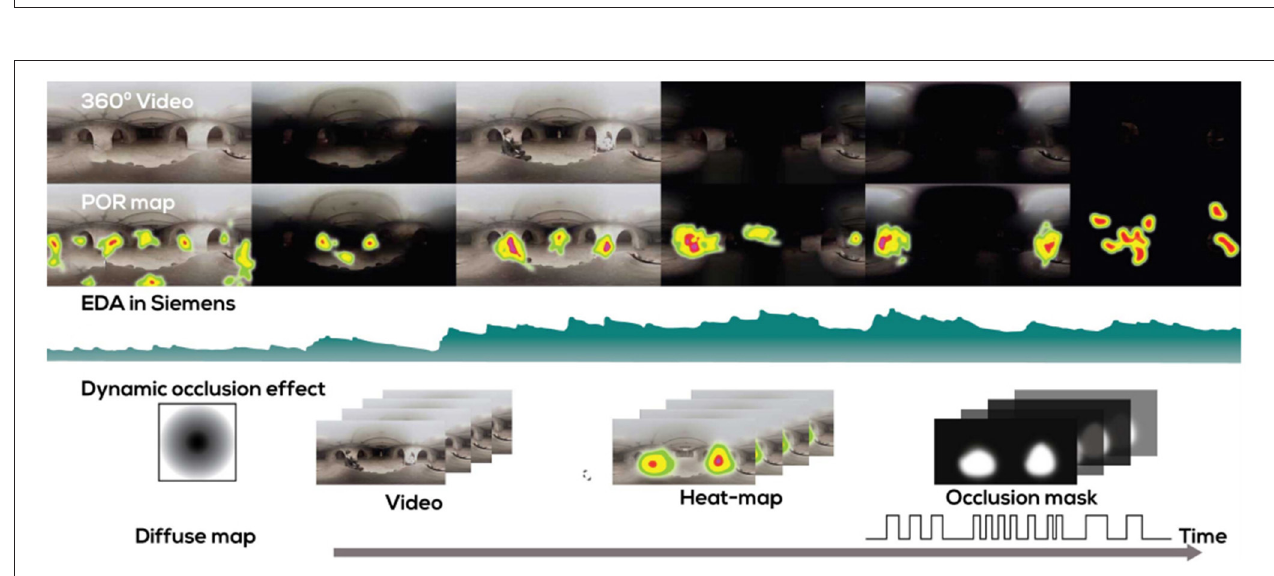
FIGURE 7 | An example of a closed-loop setup used in a lab setting. Physiological signals are recorded using a set of electrodes positioned over the visual cortex while stimuli are displayed on a VR headset. Currently, the system supports deep learning model inference for high-level cognitive states.